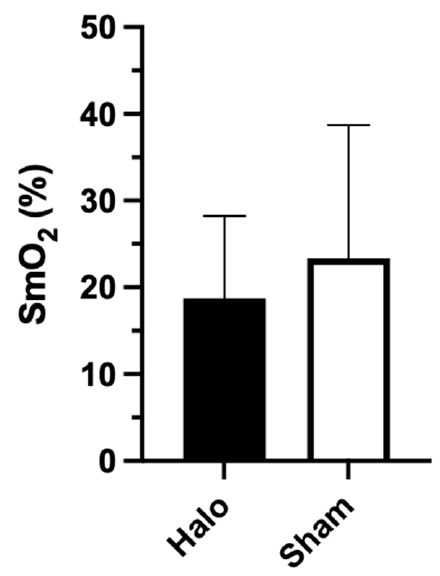
Figure 3. Muscle oxygenation results.